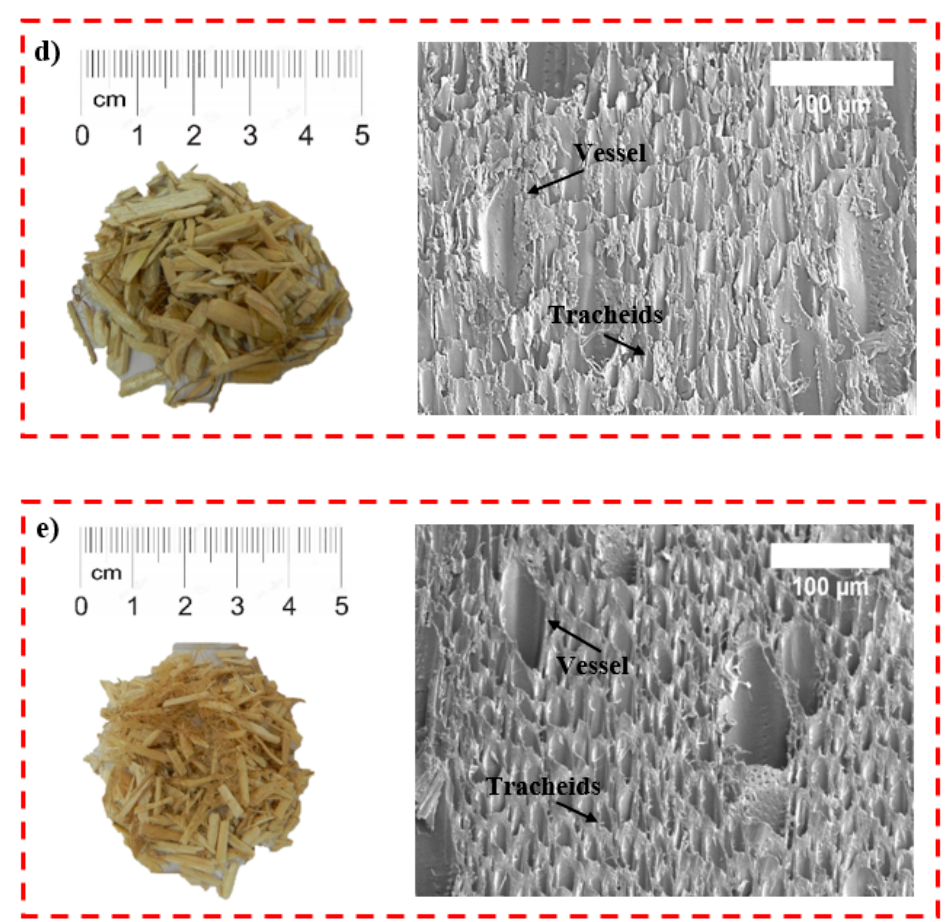
Figure 2. General views and scanning electron microscope (SEM) images of WW-based fillers: ( a ) uWS (magnification × 500), ( b ) WS (magnification × 500), ( c ) WB (magnification × 250), ( d ) HS-LT (magnification × 500) and ( e ) HS-FR (magnification × 500).